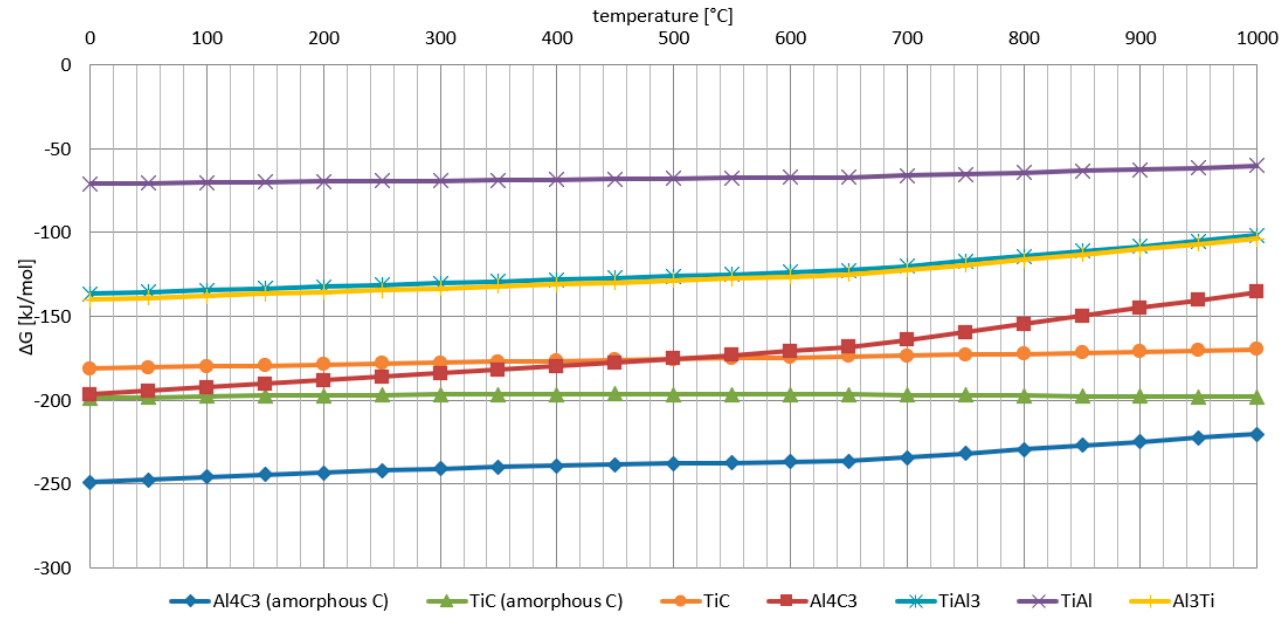
Figure 3. Schematic diagram of processes performed.